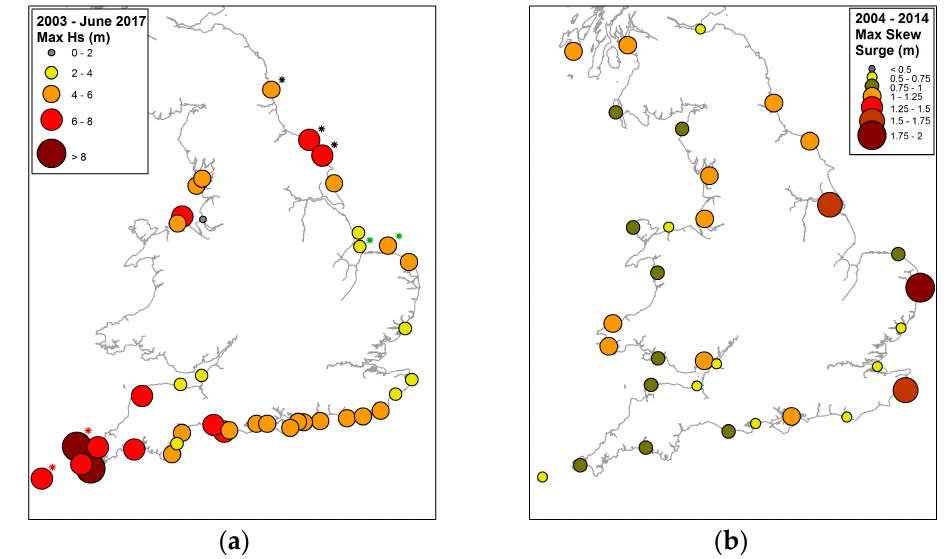
Figure 9. Maximum significant wave height measured by the wave buoy network ( a ) and maximum skew surge measured by the UK National Tide Gauge Network ( b ). The black asterisk indicates a buoy in ~15–20 m CD water depth, the green asterisk a buoy in ~2–30 m CD water depth, and the red asterisk a buoy in ~50 m CD water depth. All other buoys are in 1–15 m CD depth. Maximum skew surges were measured between 2004 and 2014, and were extracted from Haigh et al. [42].